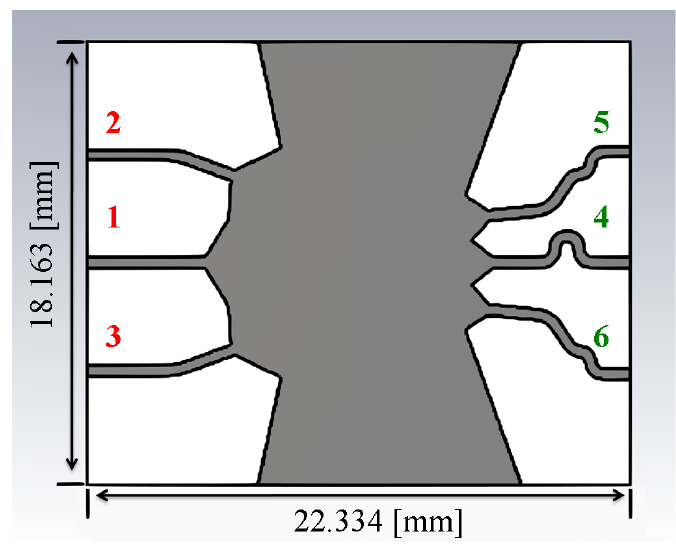
Figure 11. Rotman lens architecture with three inputs (red), three outputs (green), and two absorbers in the side walls. The scale is 10:3.06